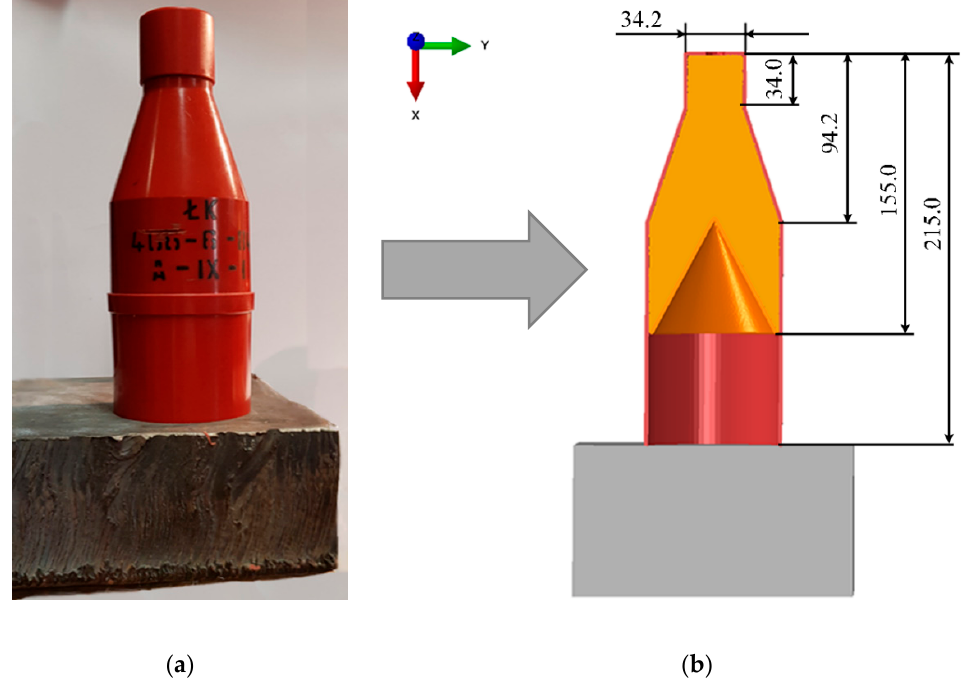
Figure 8. Models of the ŁK charge: ( a ) physical model; ( b ) geometrical model.